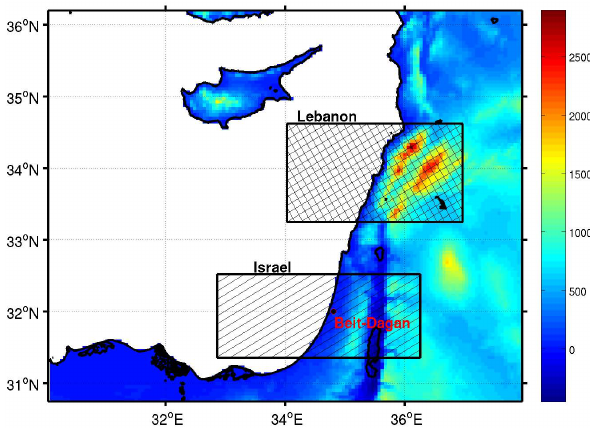
Fig. 3. Study area ROI, additional sub-regions, and Beit-Dagan me- teorological station location. The color bar represents topographic height above sea-level (m). It should be noticed that both sub- regions include two successive mountain ranges nearly parallel to the coastline, but with Lebanon’s mountains being higher and closer to the